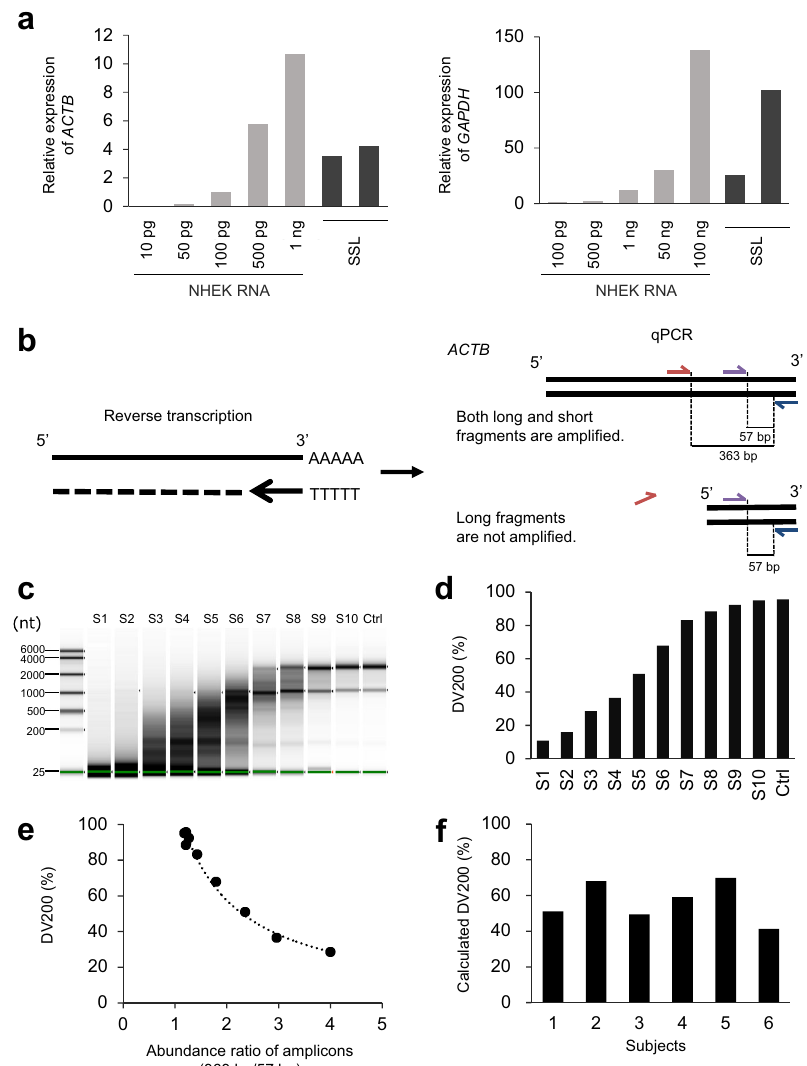
Fig. 1 Evaluation of mRNA expression and RNA degradation in skin surface lipids (SSLs). a qPCR to check for ACTB and GAPDH mRNA expression in SSL samples. Gene expression is shown as the relative expression for 100 pg of RNA derived from normal human epidermal keratinocytes (NHEK). NHEK total RNA (10 pg to 100 ng) is the standard used. b Outline for assaying the degradation of human mRNA in SSLs. The extent of mRNA degradation was determined using the long (363 bp)/short (57 bp) amplicon ratio calculated from qPCR results. c Preparation of RNA samples with different levels of degradation. A series of standards (S1 – S10) are presented with known level of RNA degradation. d DV200 value indicating the percentage of fragments containing >200 nucleotides, of c . e The relationship between the DV200 of d and the value of 363 bp/57 bp (abundance of 363 bp amplicon/abundance of 57 bp amplicon measured by qPCR). f Indirect assessment of the human mRNA degradation in SSLs, n = 6. DV200 of each SSL-RNA sample was calculated using the standard curve of e protocol 23 , we modi fi ed the experimental conditions for prepar- (0.94 and 0.90) con fi rmed that our protocol had low experimental ing the sequence library. In the modi fi ed protocol, we altered the bias (Fig. 3b). volume of reagents, standardized the conditions for reverse transcription and target ampli fi cation, and added a puri fi cation step after the target ampli fi cation to remove the primer dimers The SSL-RNA expression pro fi le predominantly re fl ects mRNA (Supplementary Method 1). With the new protocol, the success expression in sebaceous glands, epidermis, and hair follicles . rate of the library preparation improved and the AmpliSeq library The regions of the sebaceous glands, epidermis, sweat glands, hair was prepared with samples obtained from healthy subjects (91%, follicles, and dermis were isolated from the human skin sections 29/32) and patients with AD (100%, 30/30). To analyze the using LMD followed by AmpliSeq transcriptome analysis (Sup- experimental bias of our protocol, we veri fi ed the correlation plementary Fig. 1a). Each region generated distinct clusters when between the expression results of AmpliSeq and qPCR of thymus multidimensional scaling was performed to analyze the similarity and activation-regulated chemokine ( TARC / CCL17 ) and cor- of the transcriptome pro fi le in different regions (Supplementary neodesmosin ( CDSN ), and observed a high correlation ( CCL17 , Fig. 1b). Next, we focused on the genes highly expressed in each R = 0.81, CDSN , R = 0.87) (Fig. 3a). Furthermore, the correlation region (Supplementary Fig. 1c) 24 – 39 . Genes encoding ELOVL coef fi cients for the technical replicate of the reverse transcription fatty acid elongase 3 and 5 ( ELOVL3 and ELOVL5 ), perilipin 2